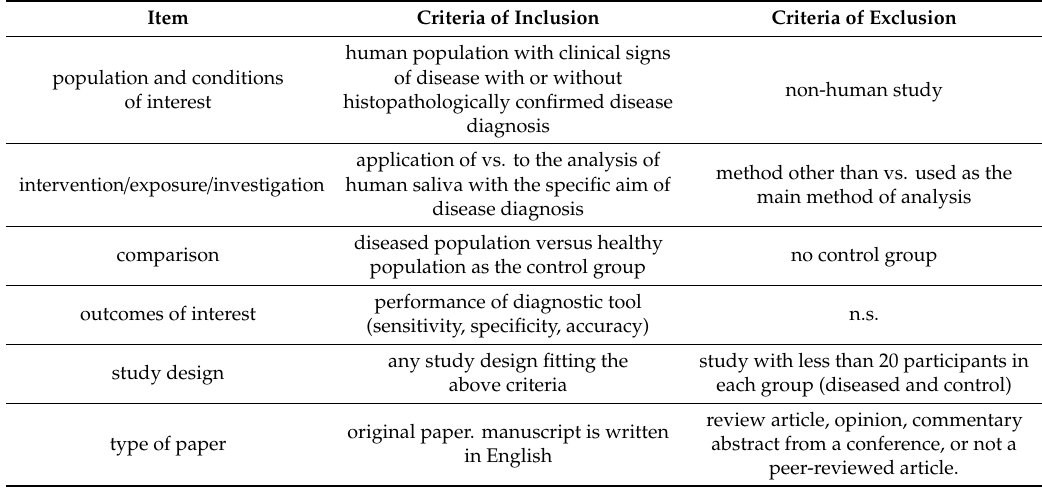
Table 4. Criteria for inclusion and exclusion of studies in the systematic